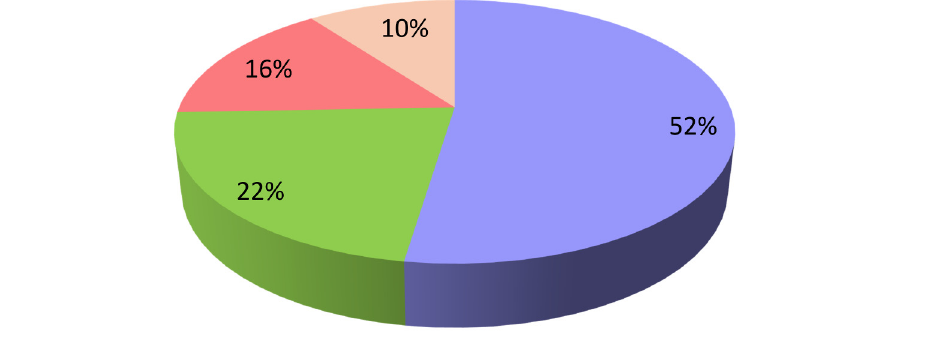
Fig 2. Preferred source to gather information related to the issues of cord blood banking.